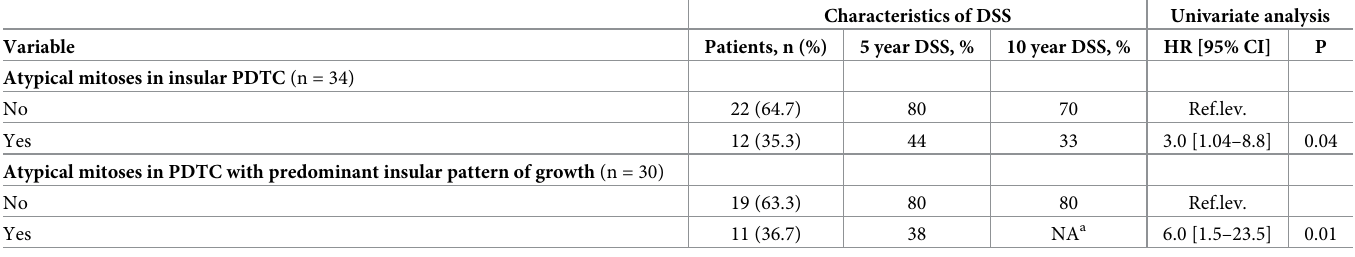
Table 4. The presence of atypical mitoses as a predictive factor of DSS in PDTC patients with an insular (n = 34), and a predominant ( > 50%) insular (n = 30), pat- tern of growth.